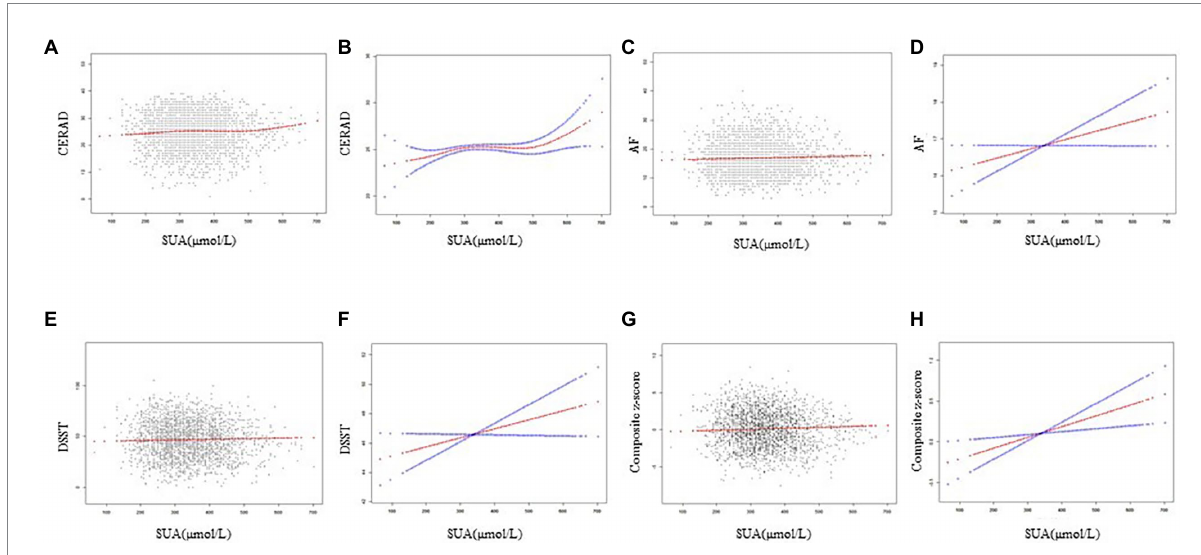
FIGURE 2 Correlation between SUA and cognitive performance. (A,C,E,G) Each black dot represents a sample. (B,D,F,H) Solid lines indicate smoothed curve fits between variables. The blue bars indicate the 95% confidence interval of the fit.